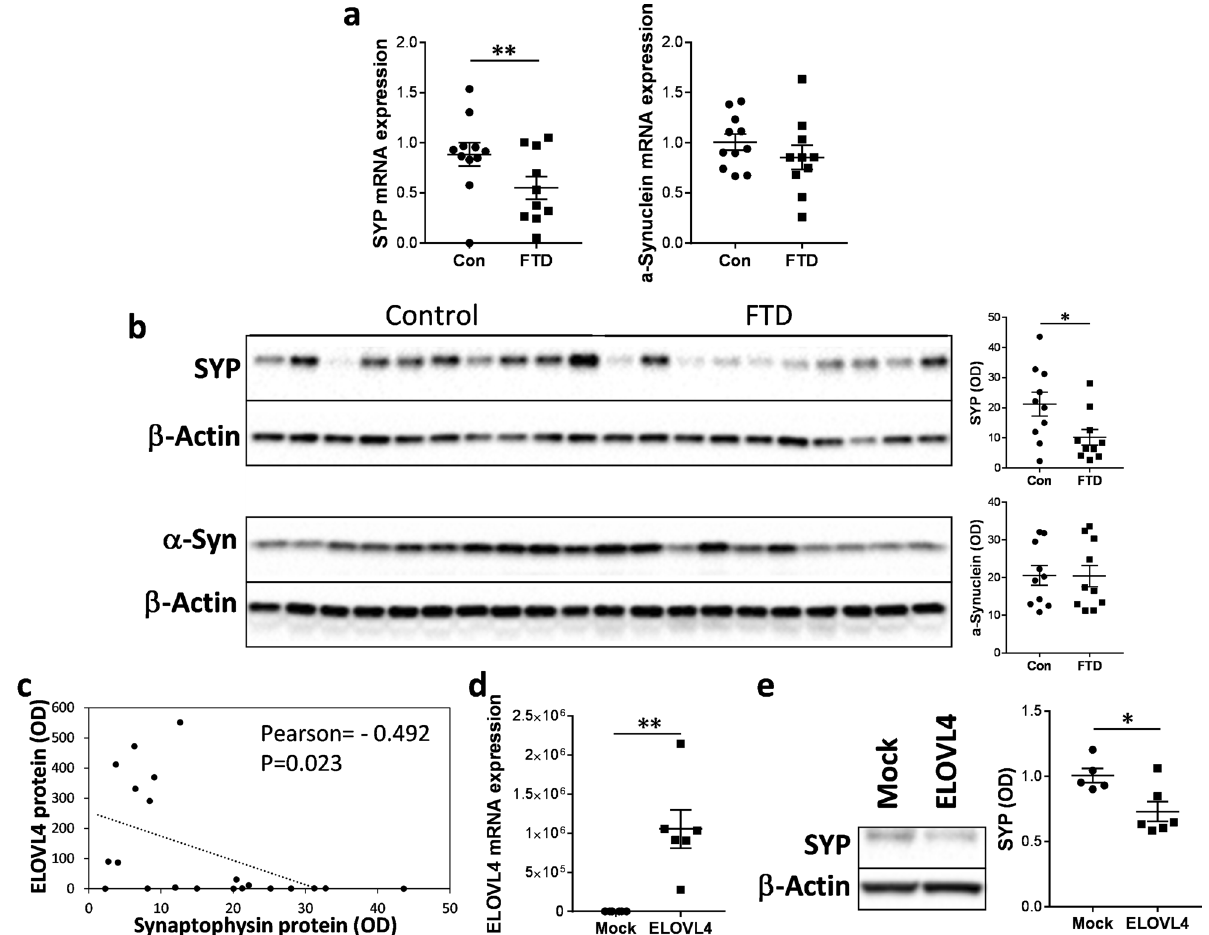
Figure 3. Dysregulation of synaptophysin in FTD brain. ( a ) mRNA expression of synaptophysin (SYP) and α-synuclein, normalized to the geometric mean of β-actin, GAPDH and PPIA, in superior frontal cortex of FTD brain (n = 10) and controls (n = 11) as measured by qPCR. Multivariate analysis (general liner model), co-varying for age and sex, was used to determine significance between the two groups. ( b ) Protein expression of SYP and α-synuclein, normalized to β-actin, in superior frontal cortex of FTD brain (n = 10) and controls (n = 10) as measured by western blotting and optical density (OD) measurements of the protein bands. Multivariate analysis (general liner model), co-varying for age and sex, was used to determine significance between the two groups. ( c ) SYP protein (OD) was inversely correlated with the 37-kDa ELOVL4 protein (OD). ( d ) SH-SY5Y neuronal cells were transfected with ELOVL4 cDNA plasmid or empty vector (mock control) (n = 6 each; 2 experimental repeats), and ELOVL4 mRNA expression, normalized to the geometric mean of β-actin, GAPDH and PPIA, measured by qPCR. Student’s t -test was used to determine significance between the two groups. ( e ) SYP protein expression in the transfected SH-SY5Y neuronal cells as assessed by western blotting and OD measurements of the protein bands normalized to β-actin. Student’s t -test was used to determine significance between the two groups. Data represent mean and SE as error bars, * P < 0.05, ** P <